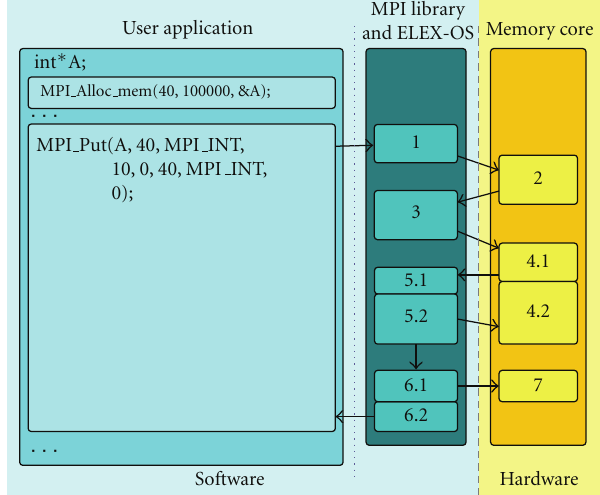
Figure 8: Application flow for sending data to the memory core using MPI